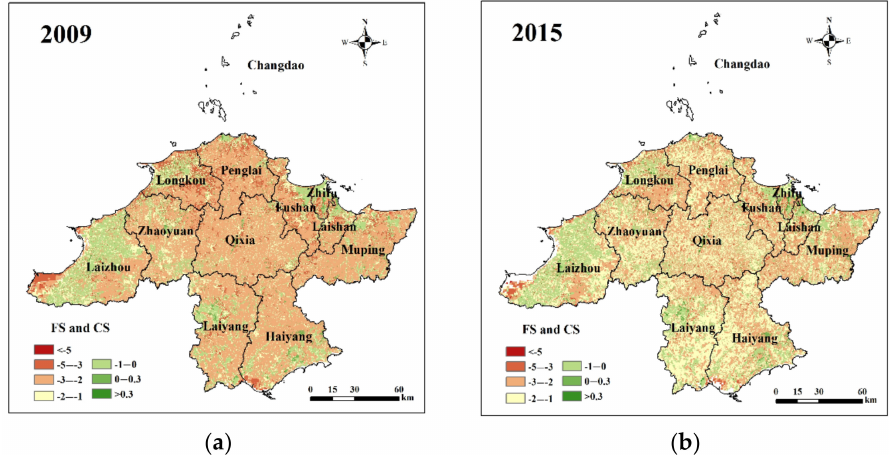
Figure 9. ( a ) Spatial synergies between food supply and carbon sequestration services in 2009; ( b ) spatial synergies between food supply and carbon sequestration services in